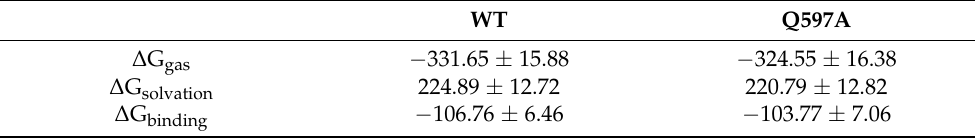
Table 1. Binding free energy (kcal/mol) between SENP1 and SUMO1 in the WT and Q597A